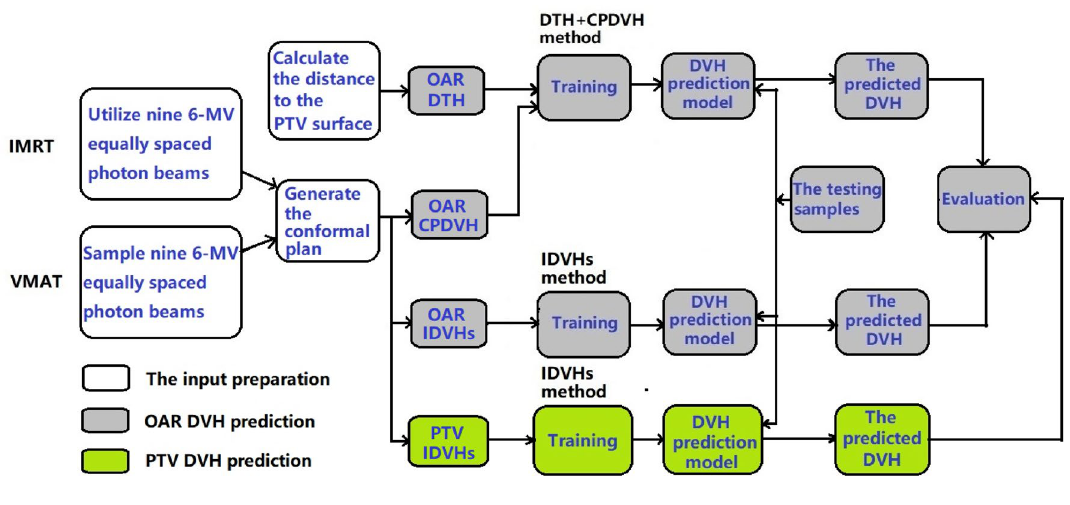
Figure 3. Flowchart showing the DVH prediction